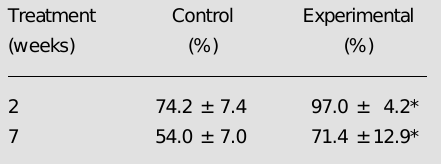
Table 1b - TBARS produced in livers of control and experimental animals.